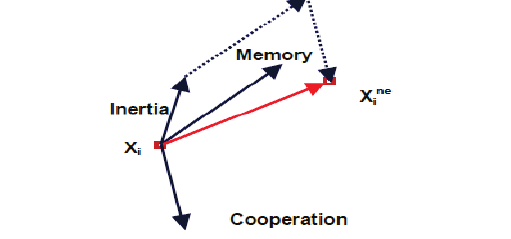
Fig.3. Particle movement